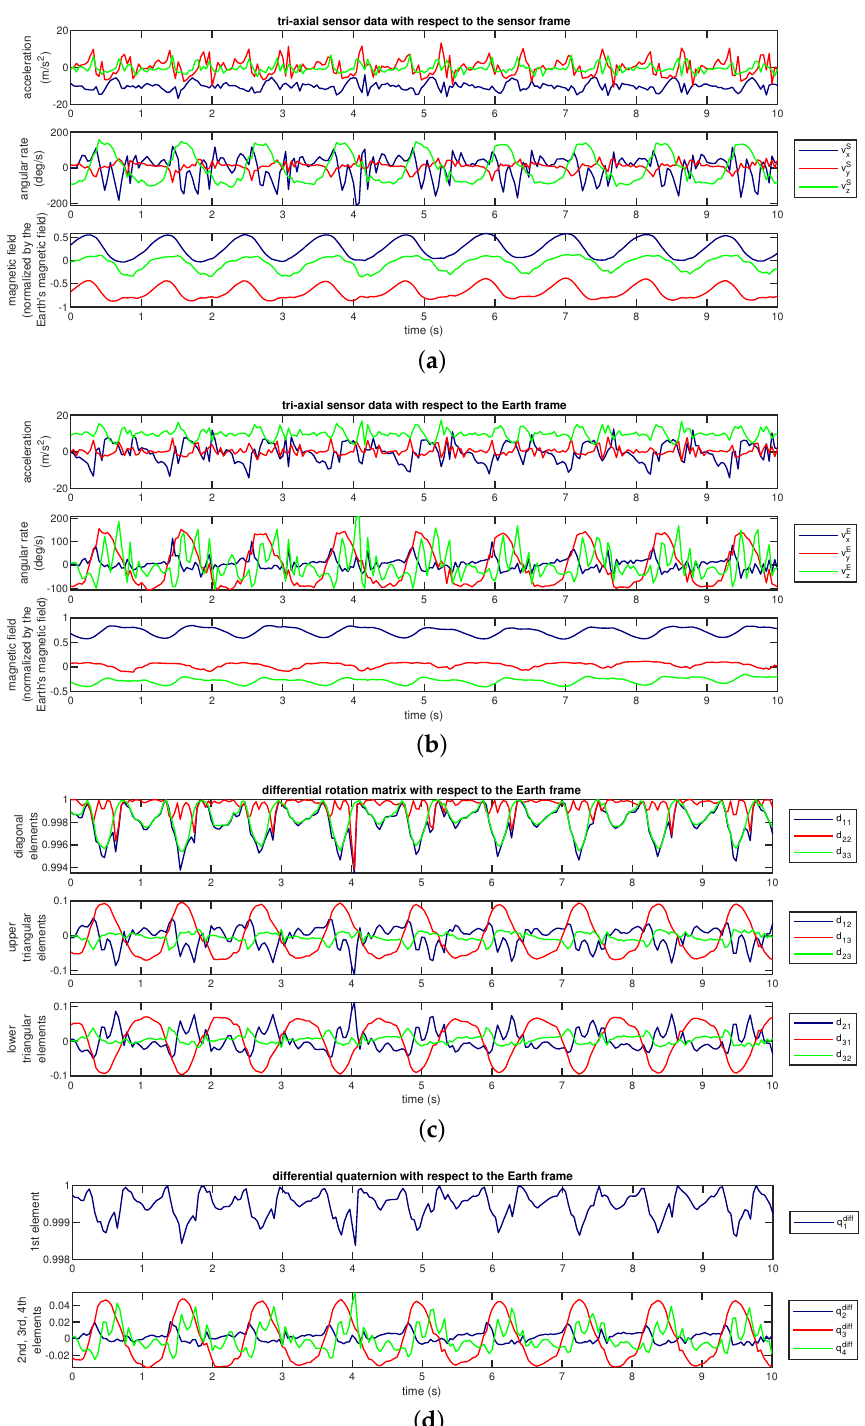
Figure 7. Original and orientation-invariant sequences from a walking activity plotted over time. ( a ) Original sensor sequences; ( b ) sensor sequences; elements of ( c ) the differential rotation matrix and ( d ) the differential quaternion. Sequences in ( b – d ) are represented in the Earth frame and are invariant to sensor